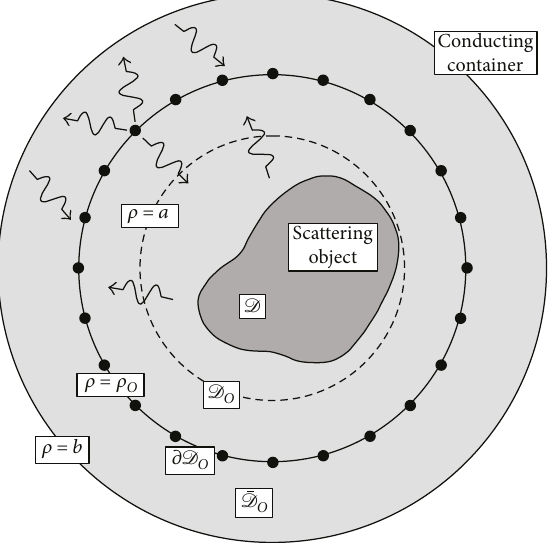
Conducting container